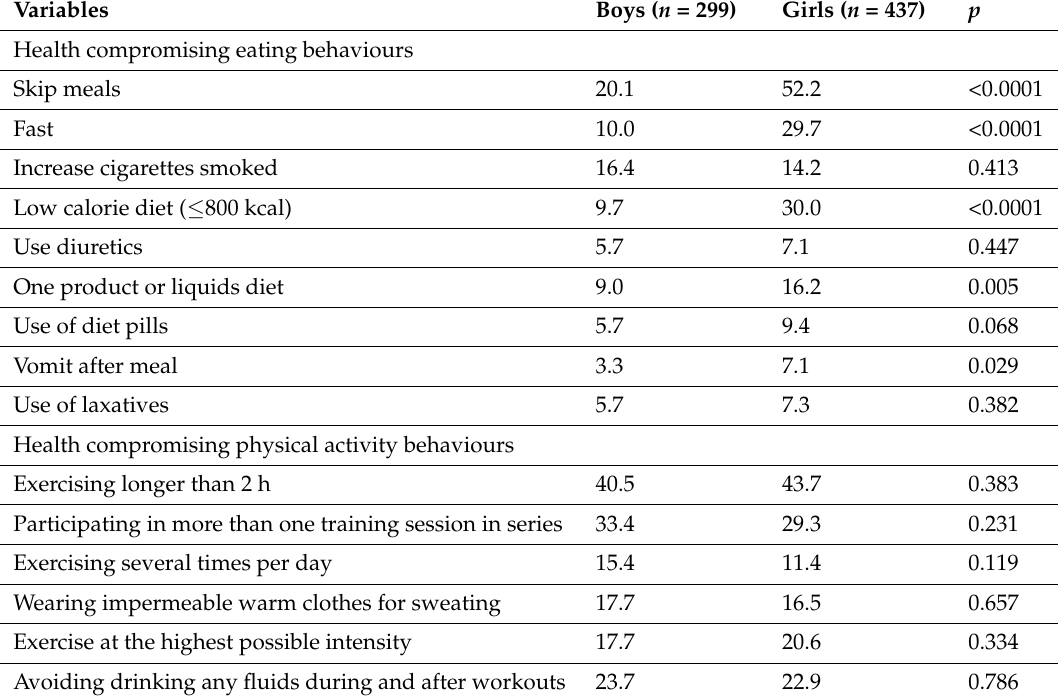
Table 2. Comparison of the health compromising eating and physical activity behaviours between boys and girls (%).